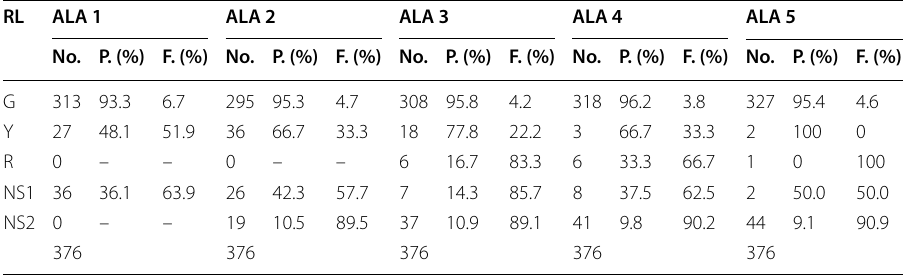
RL is the different risk levels (G, Green; Y, Yellow; R, Red; NS1, Not submitted No. is the number of learners identified in that level, P. is the percentage of learners identified in that level that passed the course, and F. is the percentage of learners in that level that failed the course